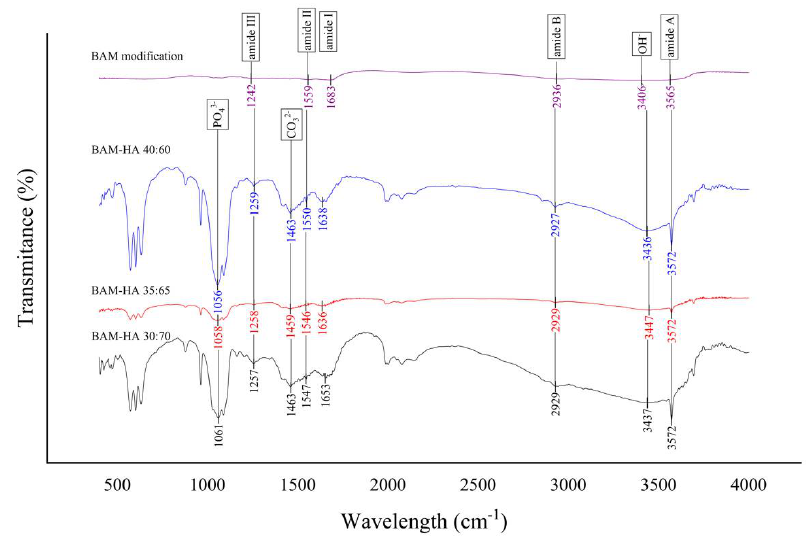
Figure 2. The result of FTIR analysis of all types of bio-composite and modified BAM.